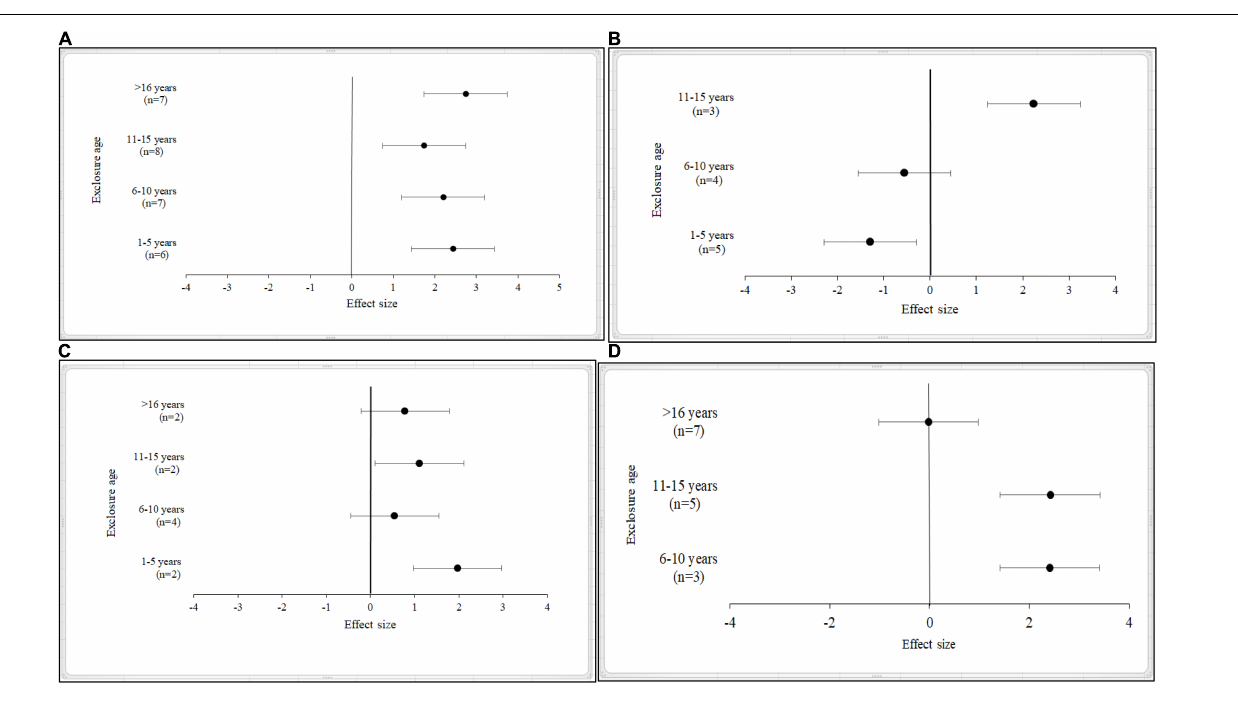
Frontiers in Ecology and Evolution |